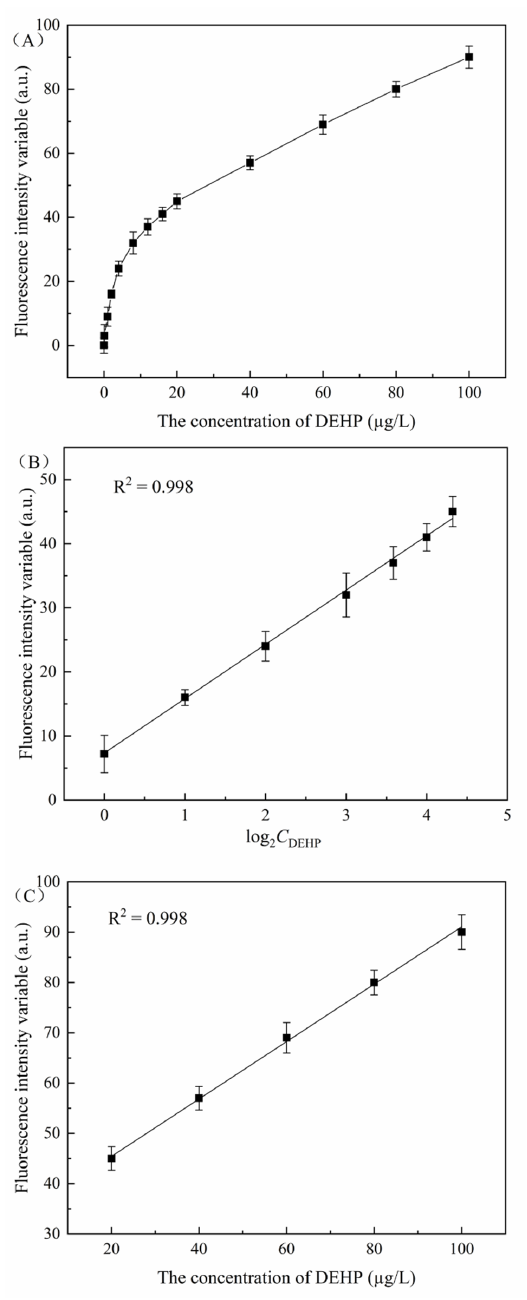
Figure 3. Quantitative detection of the DEHP fluorescence signal change value curve. ( A ) Fluores- cence signal change values in the reaction system increased when the DEHP concentration increased from 0, 0.1, 1, 2, 4, 8, 12, 16, 20, 40, 60, 80, and 100 µ g/L. The fluorescence change value is the difference between the fluorescence value measured without adding DEHP and the fluorescence value of adding DEHP at different concentrations. ( B ) The concentration of DEHP was measured in the range of 0~20 µ g/L, and the change value of the fluorescence signal was linearly correlated with the concentration of DEHP (base number of Log 2). ( C ) The concentration range of DEHP was between 20 and 100 µ g/L, and the change value of the fluorescence signal was positively proportional to the concentration of DEHP, where the fluorescence change value is the difference between the fluorescence value measured without DEHP and the fluorescence value with different concentrations of